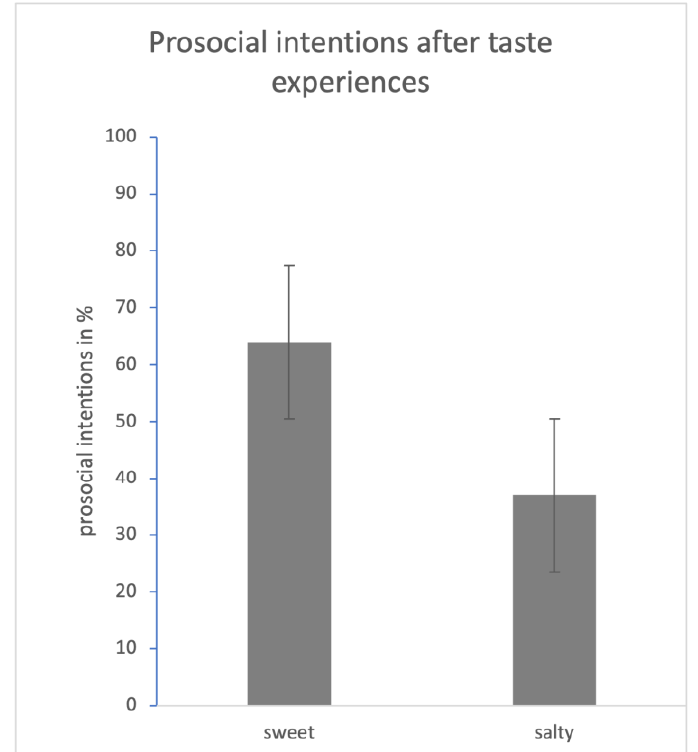
Figure 2. In this study, participants tasted sweet or salty stimuli and subsequently tested with re- spect to their actual prosocial or altruistic intentions. Prosocial intentions were more frequent when experiencing a sweet taste relative to a salty taste before. Prosocial intentions were measured by asking participants to volunteer in another unrelated study (data taken from